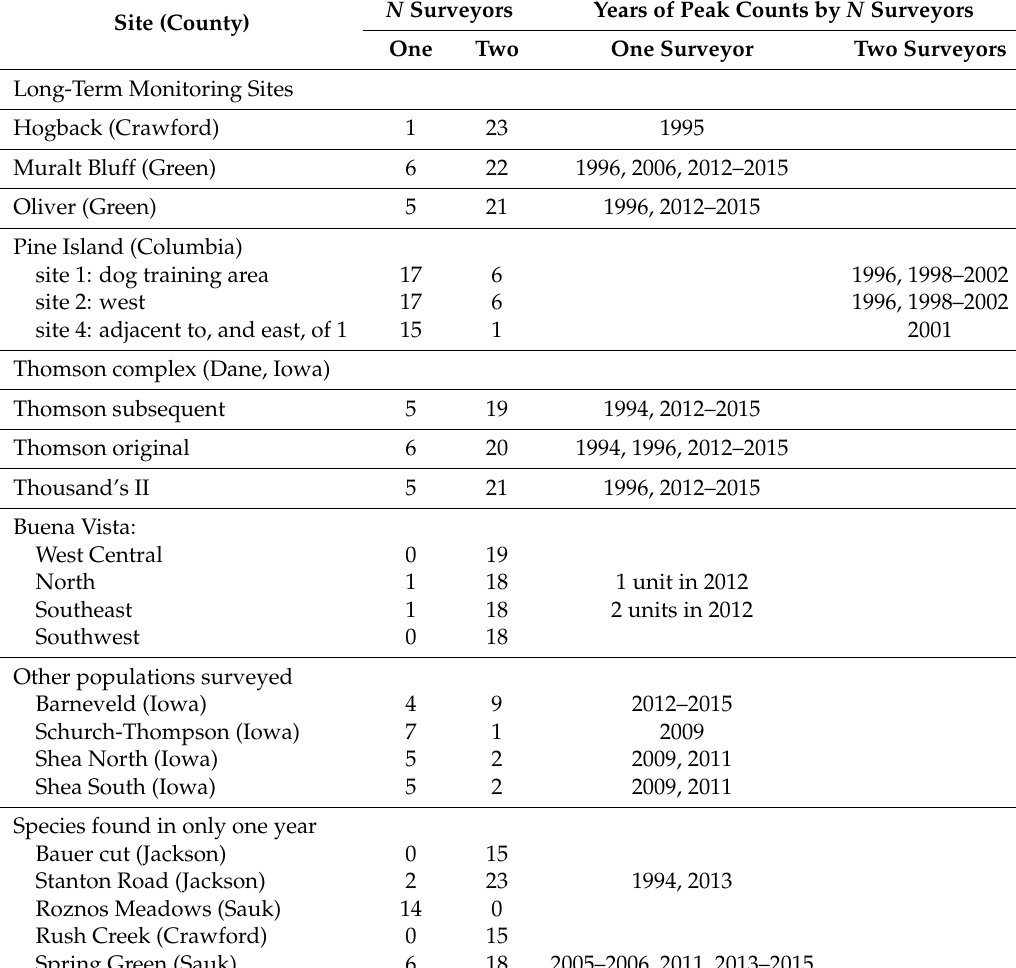
Table 1. Descriptive statistics for each site (county in parentheses) on the number of years during 1988–2015 peak counts were obtained by one surveyor or two surveyors. Before 1998, all peak counts by a single surveyor occurred in years with two surveyor visits during the flight